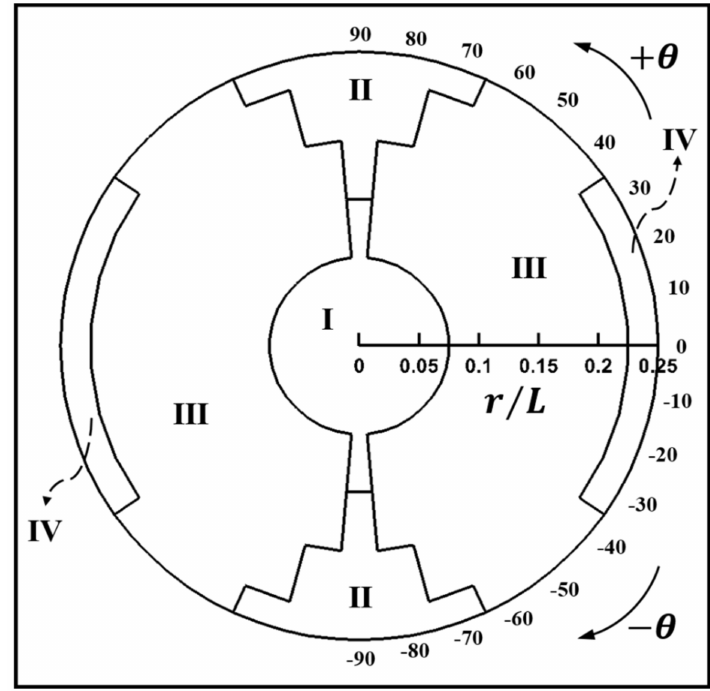
Figure 4. Map of the flow structure for Ra = 10 3